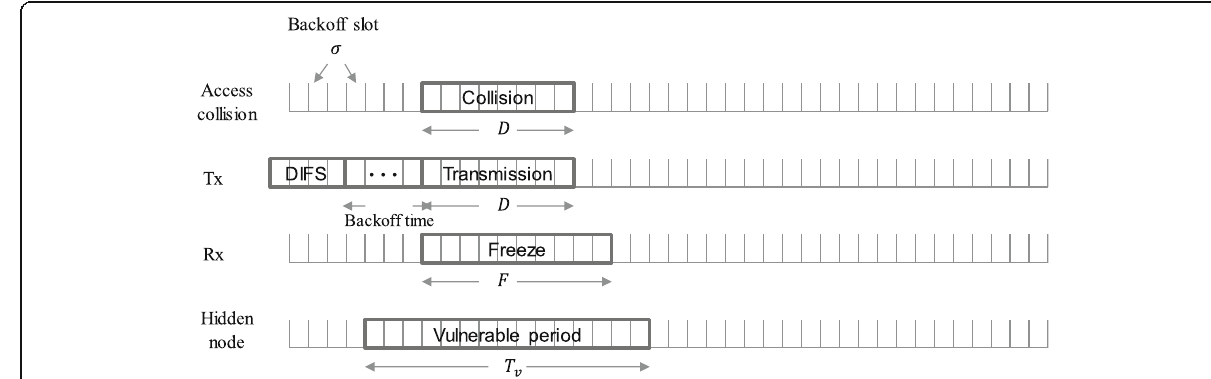
Fig. 2 Operation of 802.11p MAC as well as access collision and hidden terminal collision along with their operation time